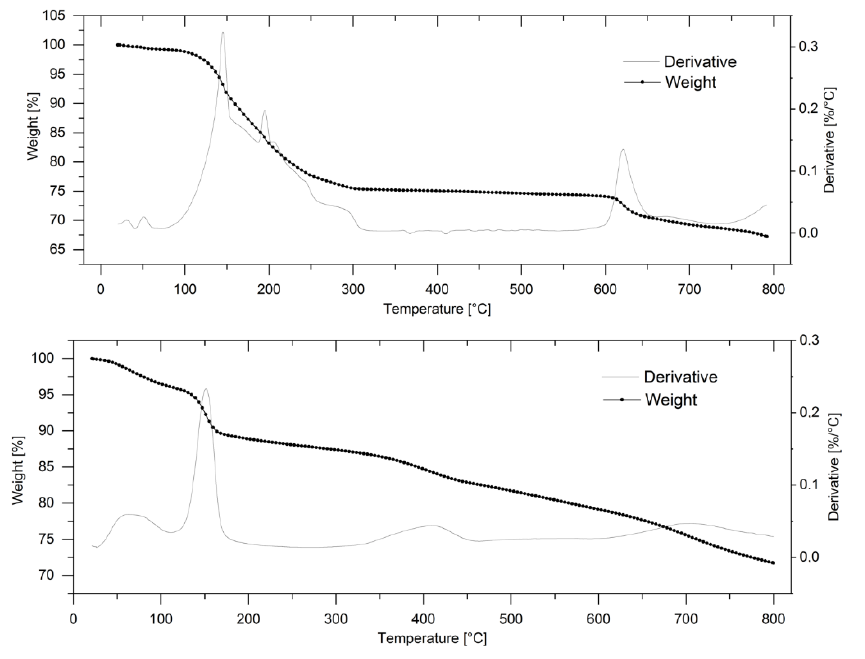
Figure 2. TG and DTG analysis of carbons coming from apricot kernel ( upper panel) and cherry stone ( lower panel) added with KOH. Heating rate 10 °C min −1 in nitrogen flow.